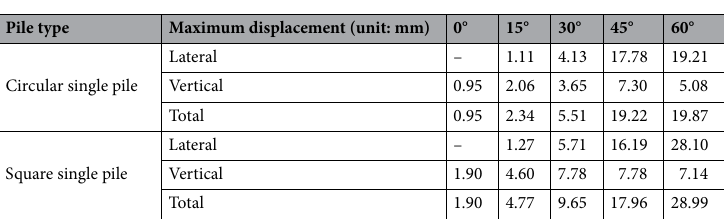
Table 3. Maximum displacement of pile top under variables initial tension angle.